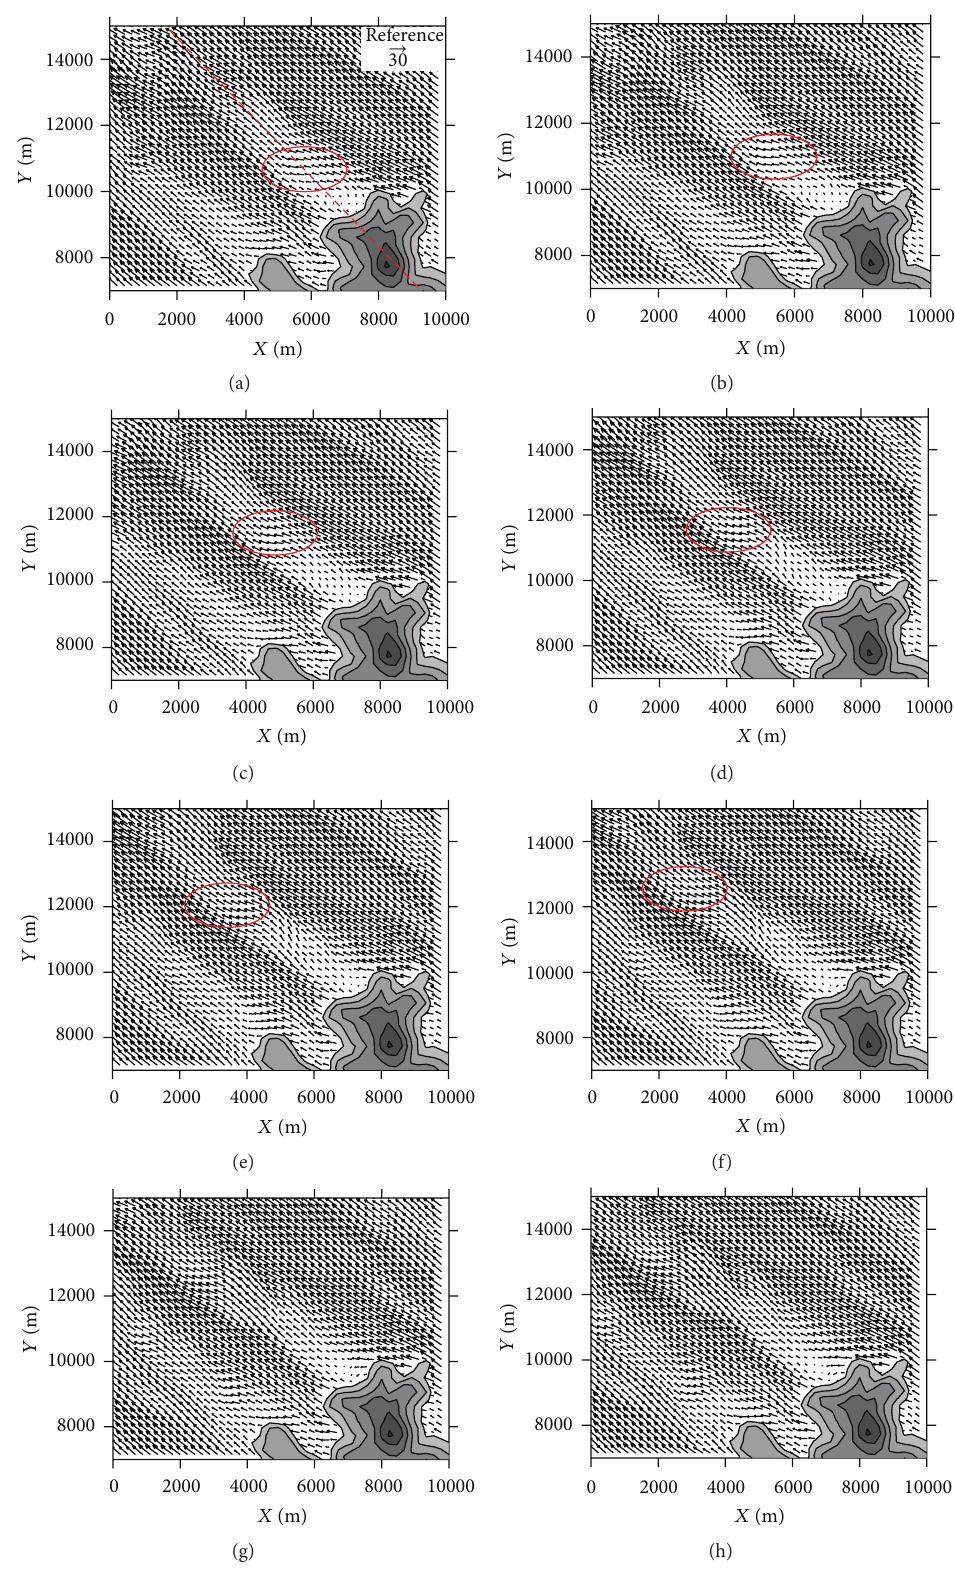
Figure 5: FLUENT simulated wind field in m/s at 220 m elevation ((a) represents the 27th minute of the simulation period with 1-minute intervals between each figure. The location of the vertical cross section in Figures 6 and 7 is shown as a red dotted line in